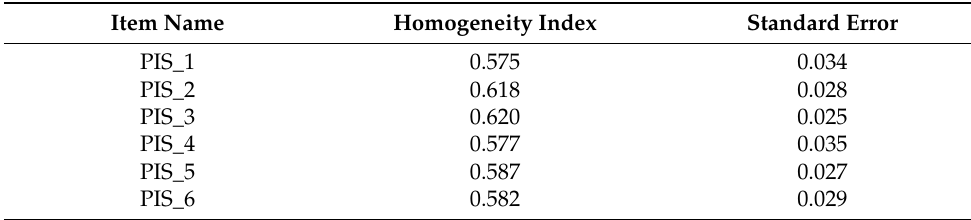
Table 1. Homogeneity analysis for PIS items.